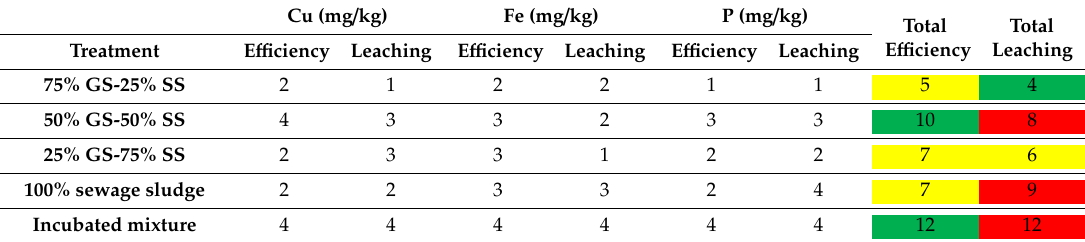
Table 6. Relative ranking colorimetric comparison of the percentages of E ffi ciency and Leaching analysed in the nutrients. The color code has been generated based on the interests of the crop and environment: the most favorable results are in green, followed by yellow, with red representing the least favorable state ( 2.4 Materials and Methods ).